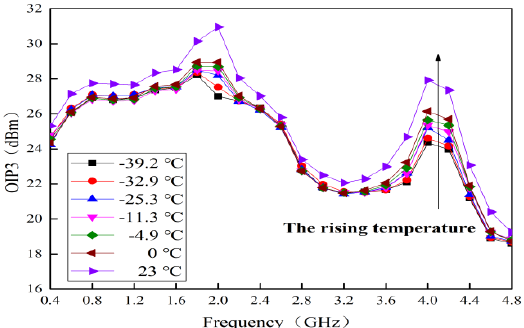
Figure 11. Measured curves of OIP3 with typical alpine temperatures.